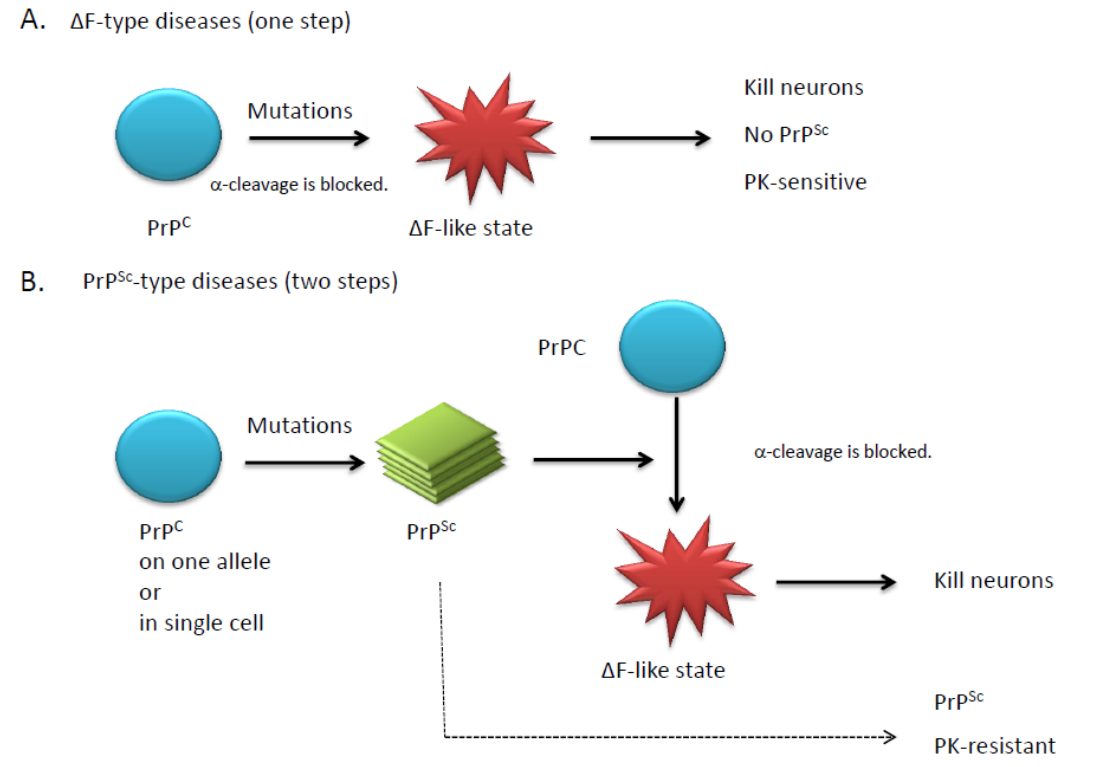
Figure 3. (A) When PrP C is not cleaved by deletion or mutation, the PrPs elicit neurotoxicity. (B) When the  -cleavage of PrP C is blocked, the unstable PrPs tend to spontaneously aggregate to generate PrP Sc . The generated PrP Sc then affect the  -cleavage of neighboring PrP C to elicit neurotoxicity or the conversion process from PrP C to PrP Sc by itself transduces a toxic signal. A mutation or deletion may occur on single allele or in single